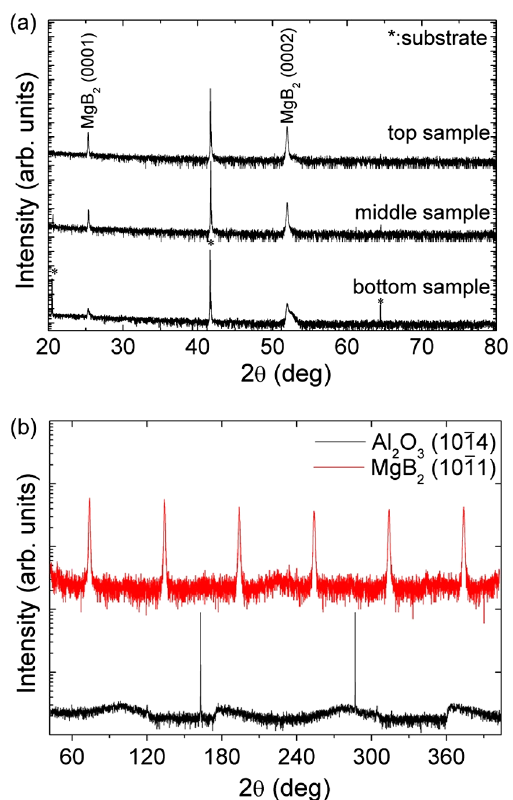
FIG. 4 (color online). XRD spectra of the MgB 2 films on (0001) sapphire substrates located in the top, middle, and bottom sample pockets on the stainless steel tube. (a) θ − 2 θ scans. The asterisks represent the peaks originating from the substrate. (b) ϕ 10¯11 10¯14 scans of the MgB 2 ( ) peak and the Al 2 O 3 ( ) peak for the top